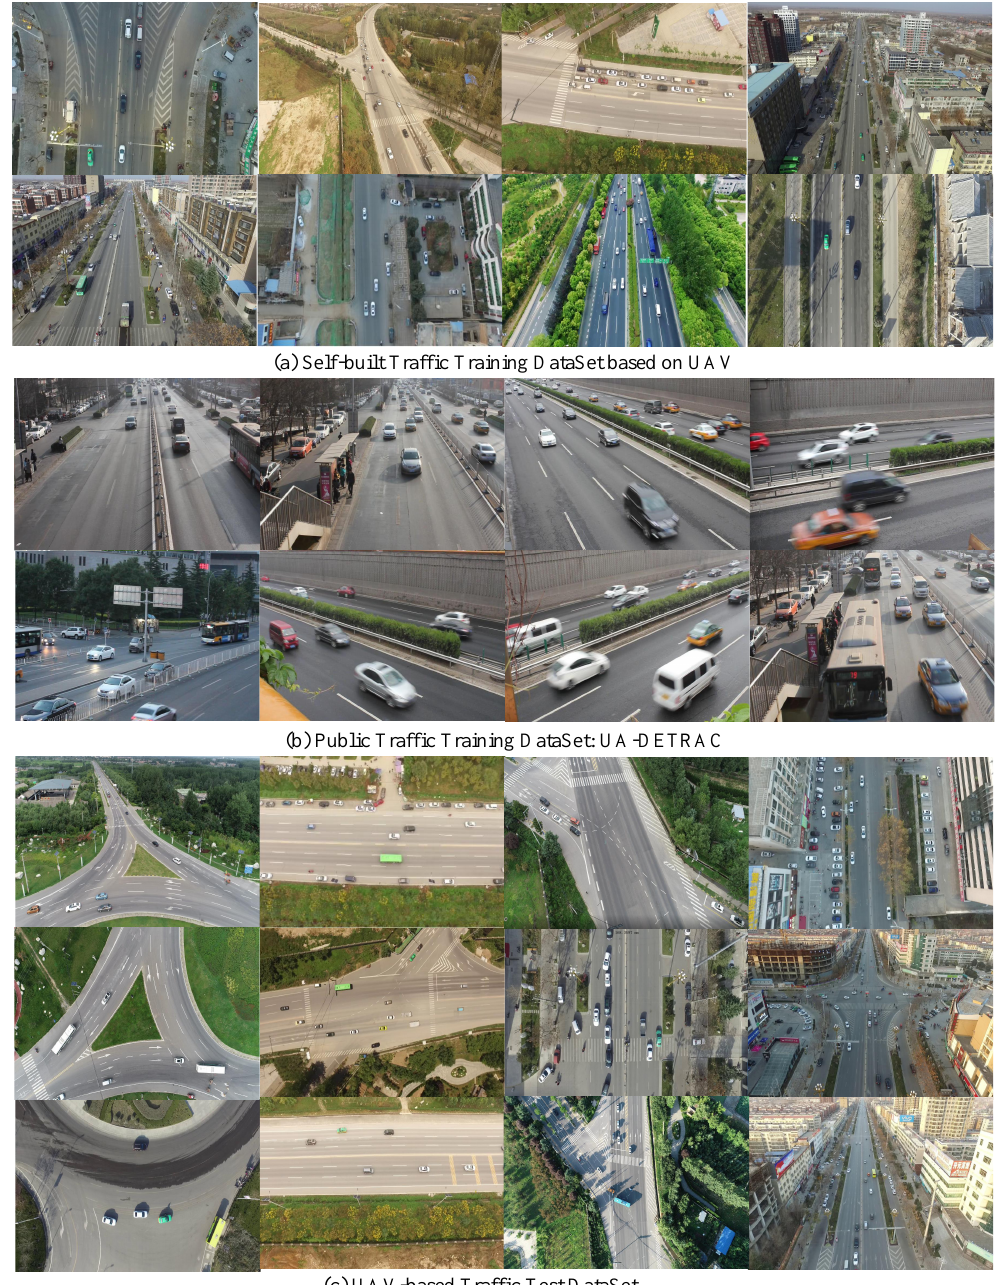
Figure 5. The training dataset Train _ UAVData included self-built training dataset ( a ) and public traffic training dataset ( b ). Test _ UAVData ( c ) has images which were taken by us using a drone equipped with a point gray monocular camera in a variety of